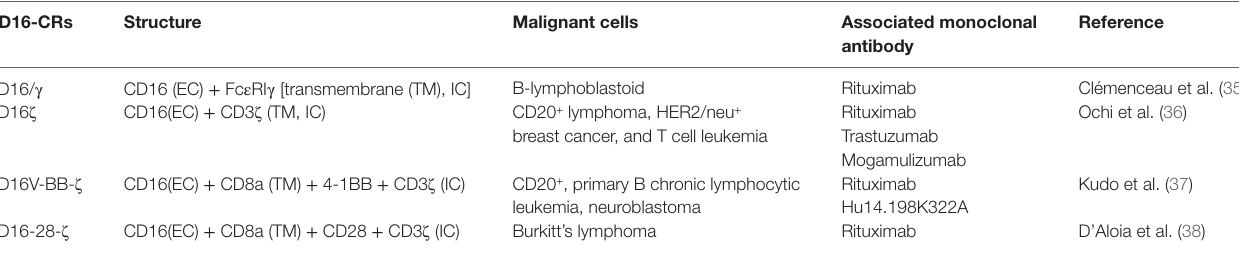
TABLe 2 | Summary of published preclinical studies involving CD16-CR-engineered T cell-based immunotherapy.